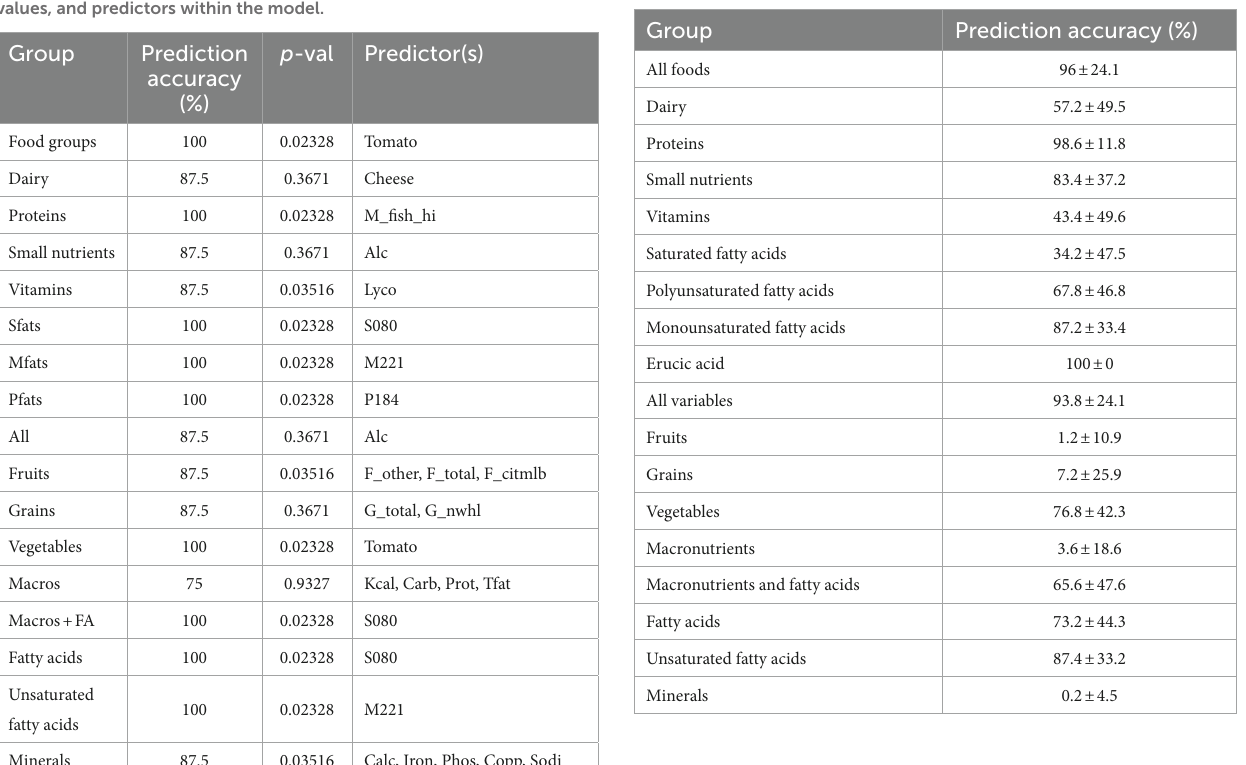
TABLE 5 Random forest prediction